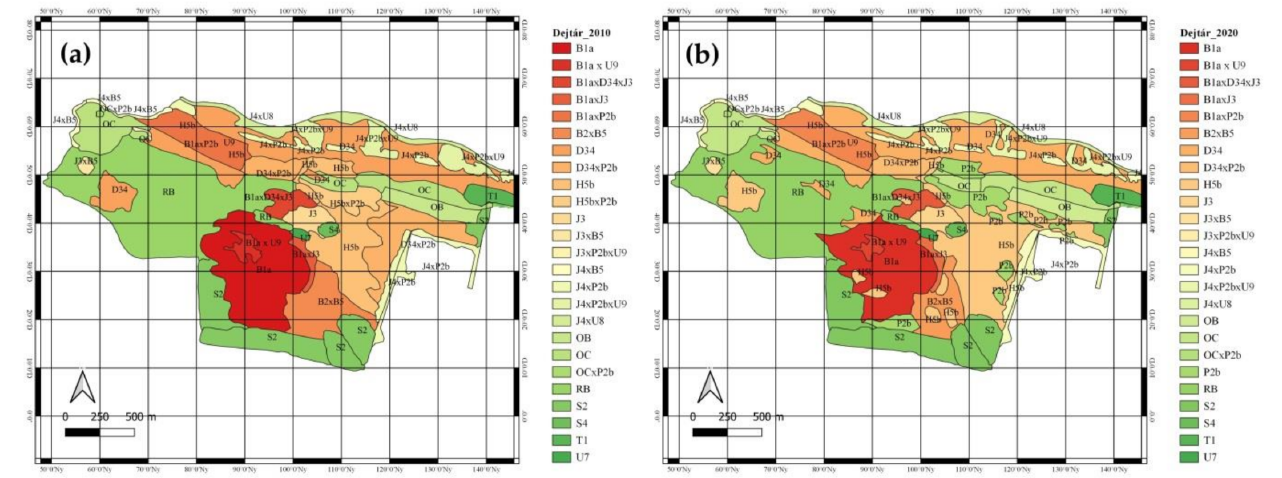
Figure 2. Habitat maps of Dejt á r area in 2010 ( a ) and 2020 ( b ). The main difference in habitats between the two maps is that there are two different complexes. On the 2010 map, we can find the H5b × P2b complex, which is noticeably sep- arated by 2020. Therefore, for the year 2020, H5b and P2b were recorded separately. In both years, only seven categories (B1a × D34 × J3, J3, J3 × P2b × U9, J4 × B5, J4 × P2b × U9, J4 × U8 and U7) were presented entirely, thus most of the complexes were transformed. The map made in the wetter year (2010) shows the decreasing trend of the aquatic vegetation in low-lying woodless habitats. A significant change occurred in the closed sand steppes (H5b) and the aspects of their subtypes, too. They went through a total transformation and their presence was lower in 2010 than in 2020. Their area was 70.4 hectares in 2010, then it increased to 145.5 hectares in 2020. According to the maps, the vegetation changed significantly in the compared years, under extremely dry conditions (2020) and in the extremely wet year (2010). The two examined years’ vegetation showed a huge difference, which appropriately indicated the environmental changes. The extension of grassland increased significantly. Areas of closed sand steppes (H5b) increased due to the presence of persistent rainfall shortages, the number of plots extremely increased from 6 (in 2010) to 14 (in 2020). To sum up, it can be observed that the presence of dry habitats increased and several dry fragments were formed within 10 years (Figure